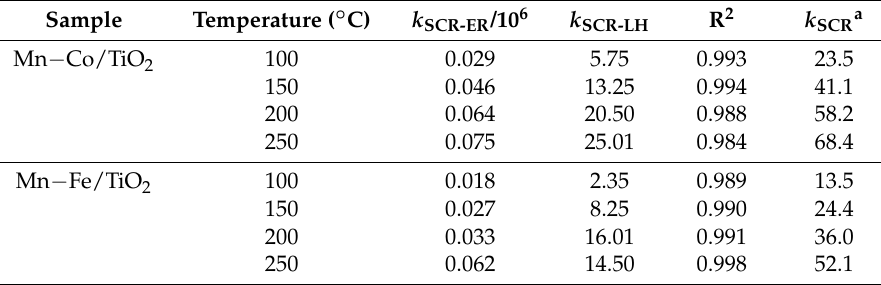
Table 5. Reaction kinetic constants of NO reduction.